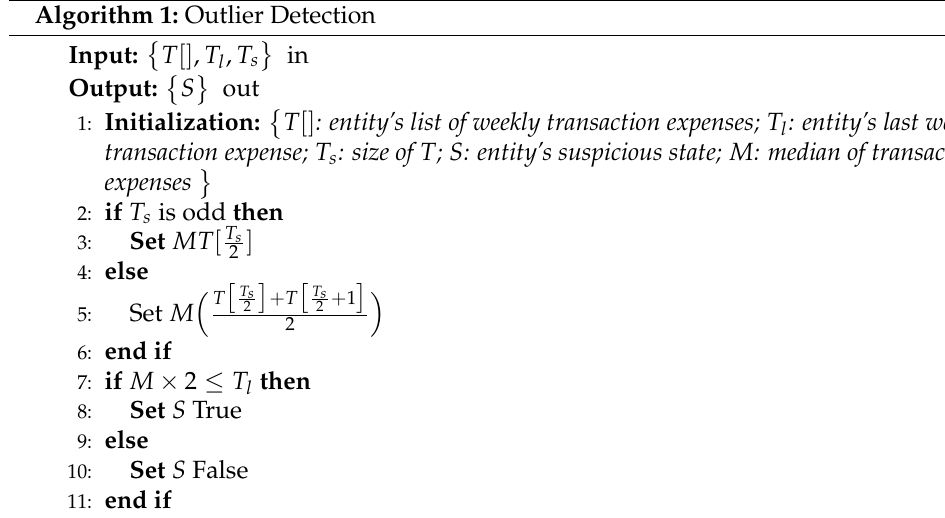
Algorithm 1: Outlier